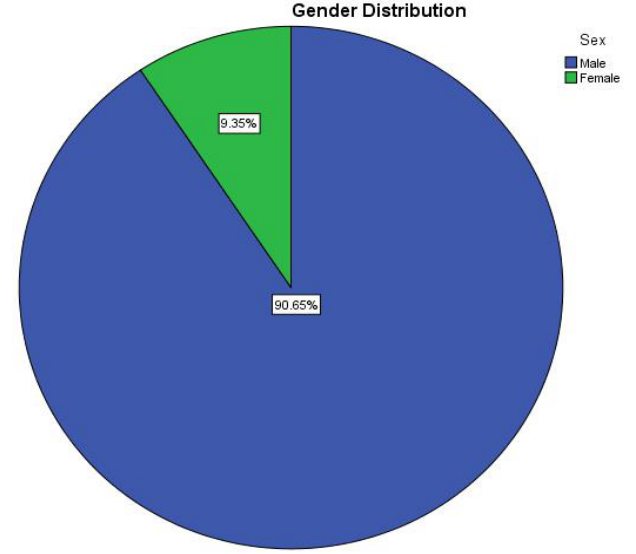
Fig 1. Etiologic distribution of patients.